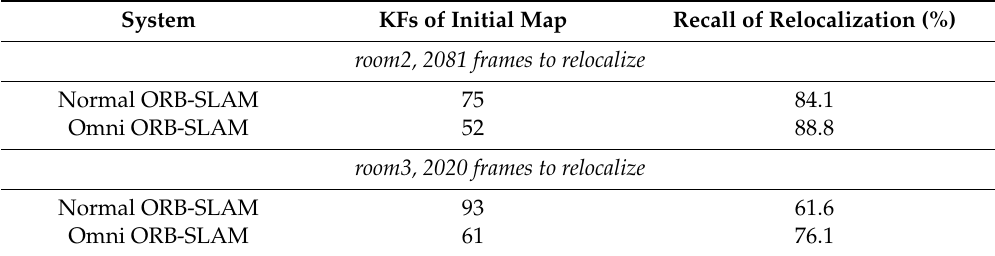
Table 3. Results for the Relocalization Experiments. KF = Kalman